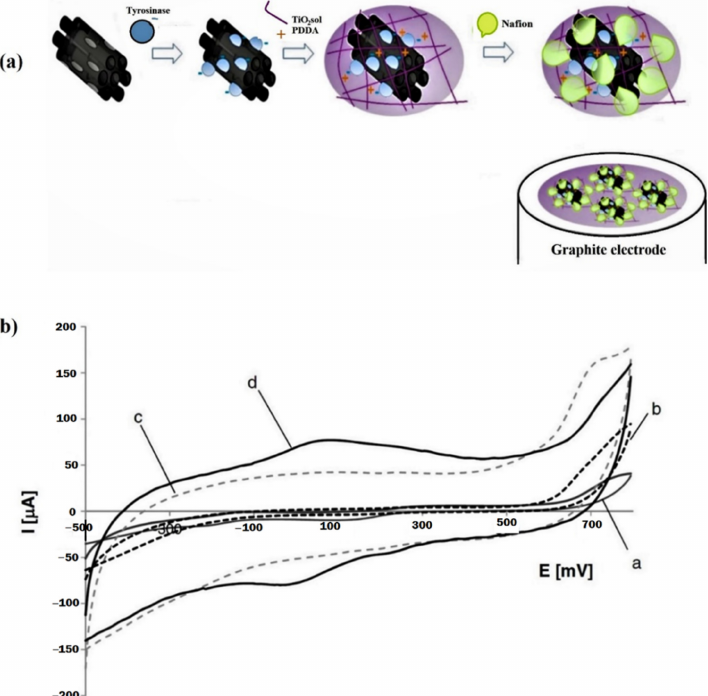
Figure 2. ( a ) Schematic representation of an multi walled carbon nanotube (MWCNT)modified graphite electrode for tyrosine detection, ( b ) Cyclic voltammograms collected at 0.48 mM tyramine solution at a : Tyrosinase/TiO 2 , b : Tyrosinase/TiO 2 /polycationic polymer/Nafion, c : Tyrosinase/TiO 2 /MWCNT/Nafion, and d : Tyrosinase/TiO 2 /MWCNT/polycationic poly- mer/Nafion biosensors. Reprinted (adapted)with permission from Ref. [36]. Copyright 2016, Springer